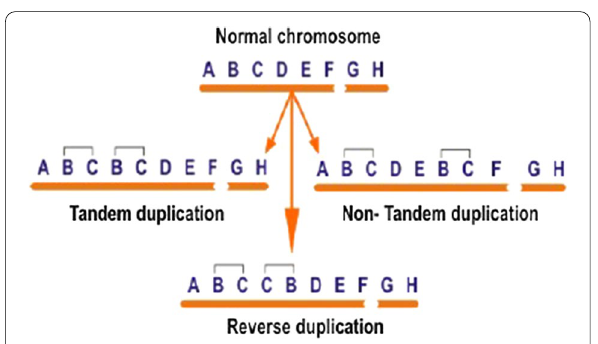
Fig. 9 Chromosomal